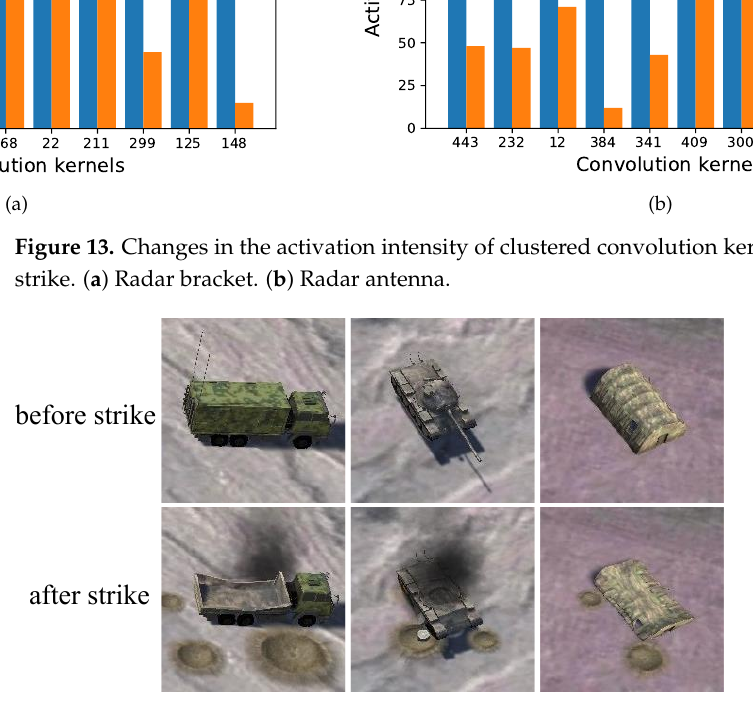
Figure 14. Image changes before and after the strike. Table 2. Clustered convolution kernels for the targets’ different components. Different Components Feature Maps of the Top 10 Activation Intensity (from Large to